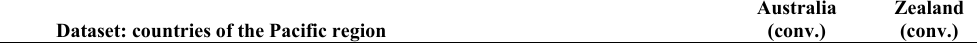
Datas е t: countries of the Pacific region Performance indicator